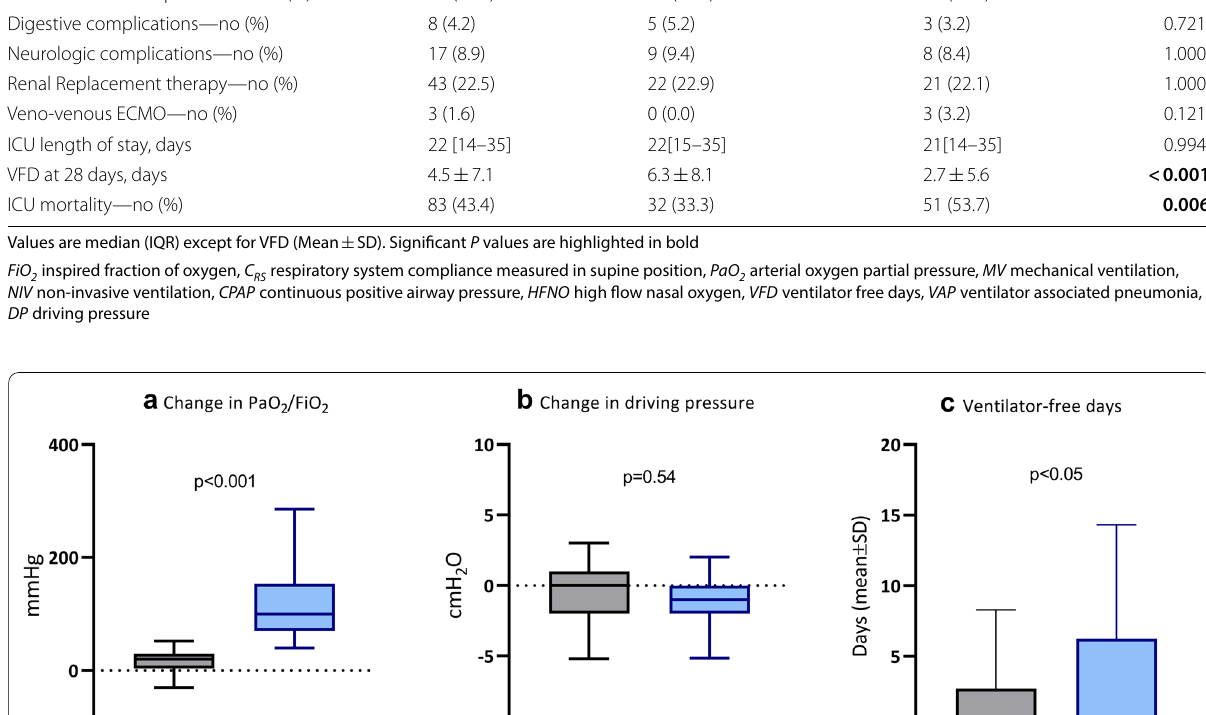
Fig. 1 Physiologic effect of the first prone positioning session and impact on patient outcome. Effect of the first proning session on change in PaO 2 /FiO 2 ratio ( a PaO 2 /FiO 2 in after prone position minus PaO 2 /FiO 2 before prone position), change in driving pressure ( b driving pressure after prone position minus driving pressure before prone position) and ventilator-free days ( c ) in responders (blue) and non-responders (grey) patients with acute respiratory distress syndrome related to